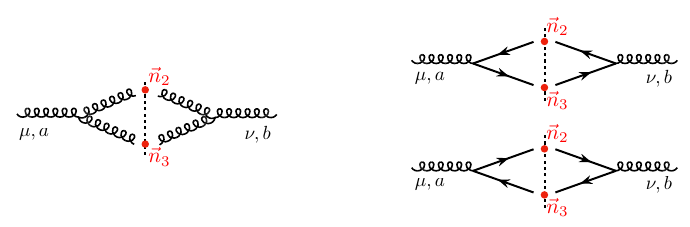
Figure 5. Feynman diagrams contributing to the leading order matching of the E ( ~n 2 ) E ( ~n 3 ) OPE onto the twist-2 gluon operator O g and O ˜ g,λ